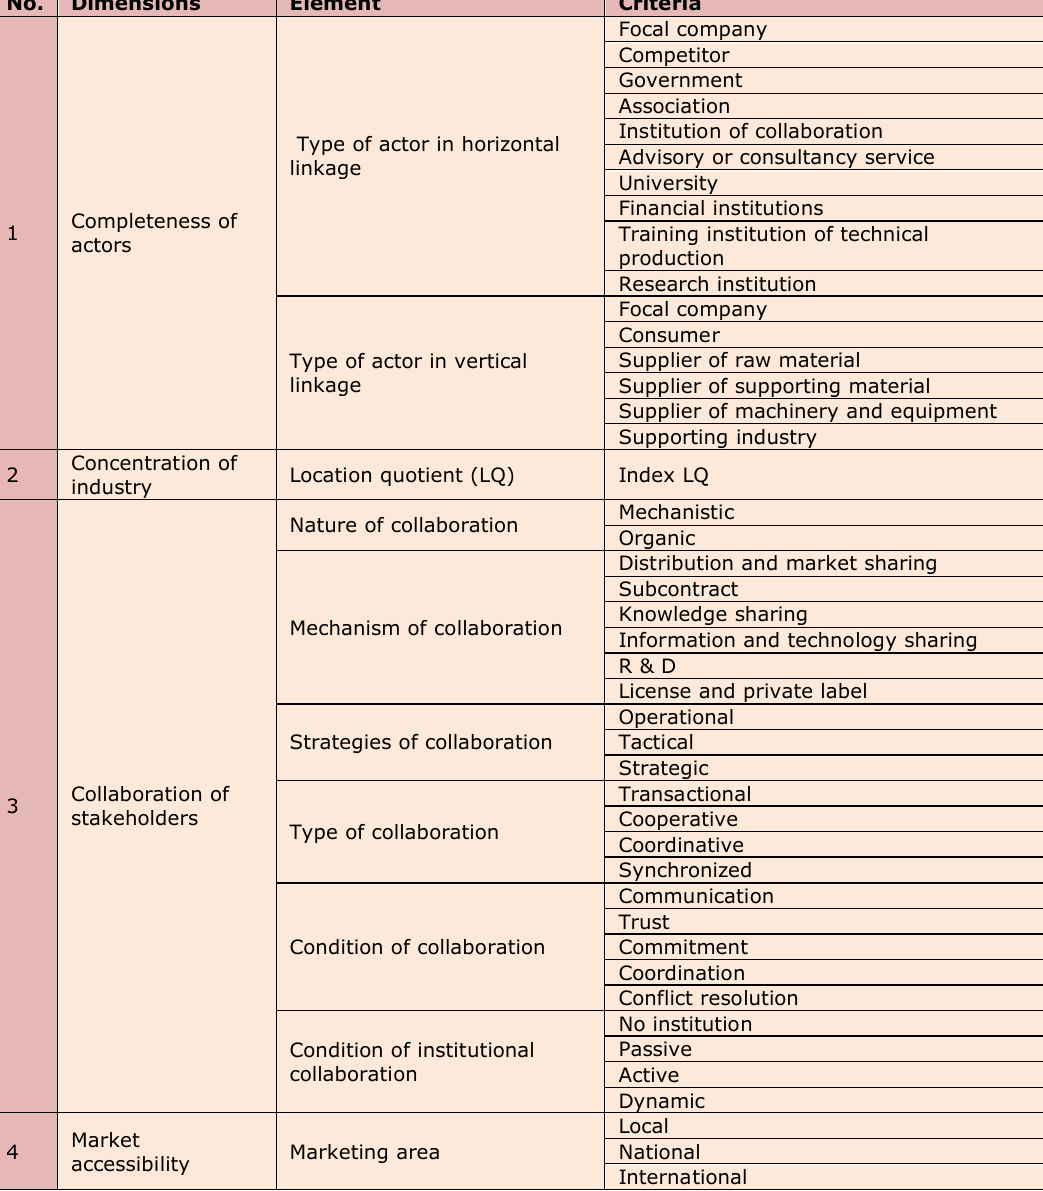
Table 3. Assessment criteria to identify phases of industrial cluster life